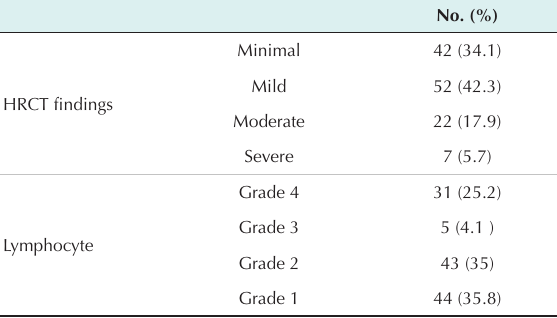
Table 3. Frequency of Patients with COVID-19 Based on HRCT Findings and Lymphocyte